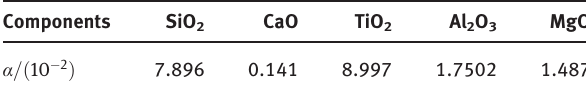
Table 3: Activities of different components in the titanium-bearing blast furnace slag. Components